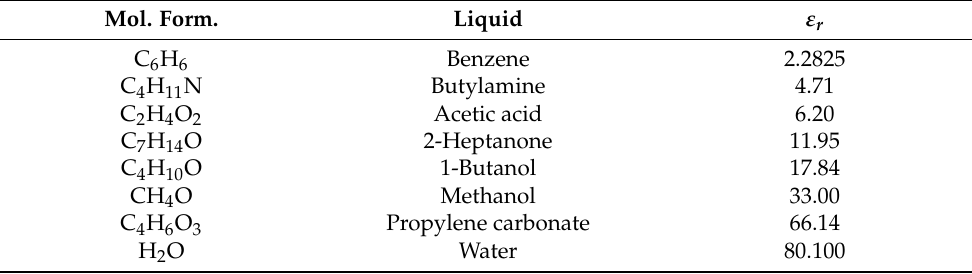
Table 3. The relative permittivity ( ε r ) of liquids used for calibration, measured in static fields or at low frequencies at 20 ◦ C and standard atmospheric pressure [44]. Mol.